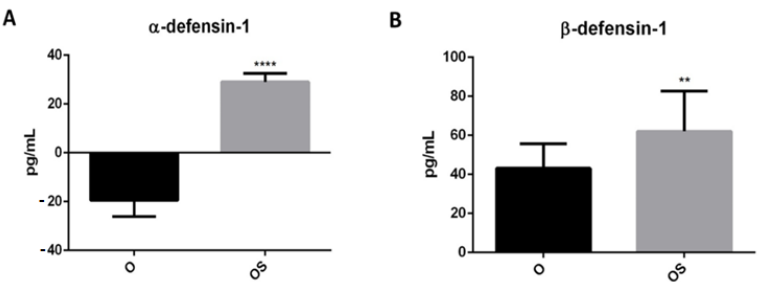
Figure 5. Accumulation of defensins in serum of sedentary obese children (OSe) compared to obese children who played sport (OSp). ( A ) α -defensin-1 and ( B ) β -defensin-1. The data are expressed as the means ± SDs. The significance was determined by the Student’s t -test: ** ( p < 0.01) and **** ( p < 0.0001), which represent significance compared to sedentary obese children.